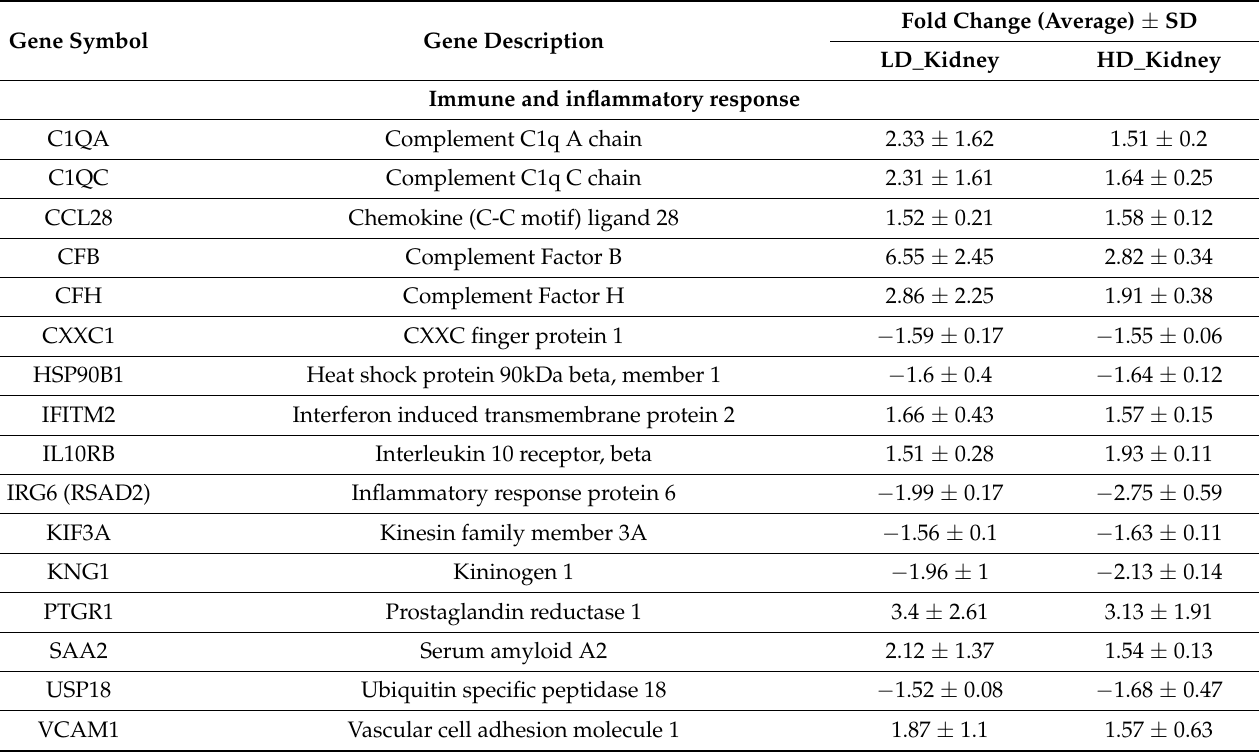
Table 2. Commonly regulated genes in kidney after low- and high-dose diclofenac treatment. A total of 66 statistically significant DEGs were regulated in common amongst low- and high-dose diclofenac